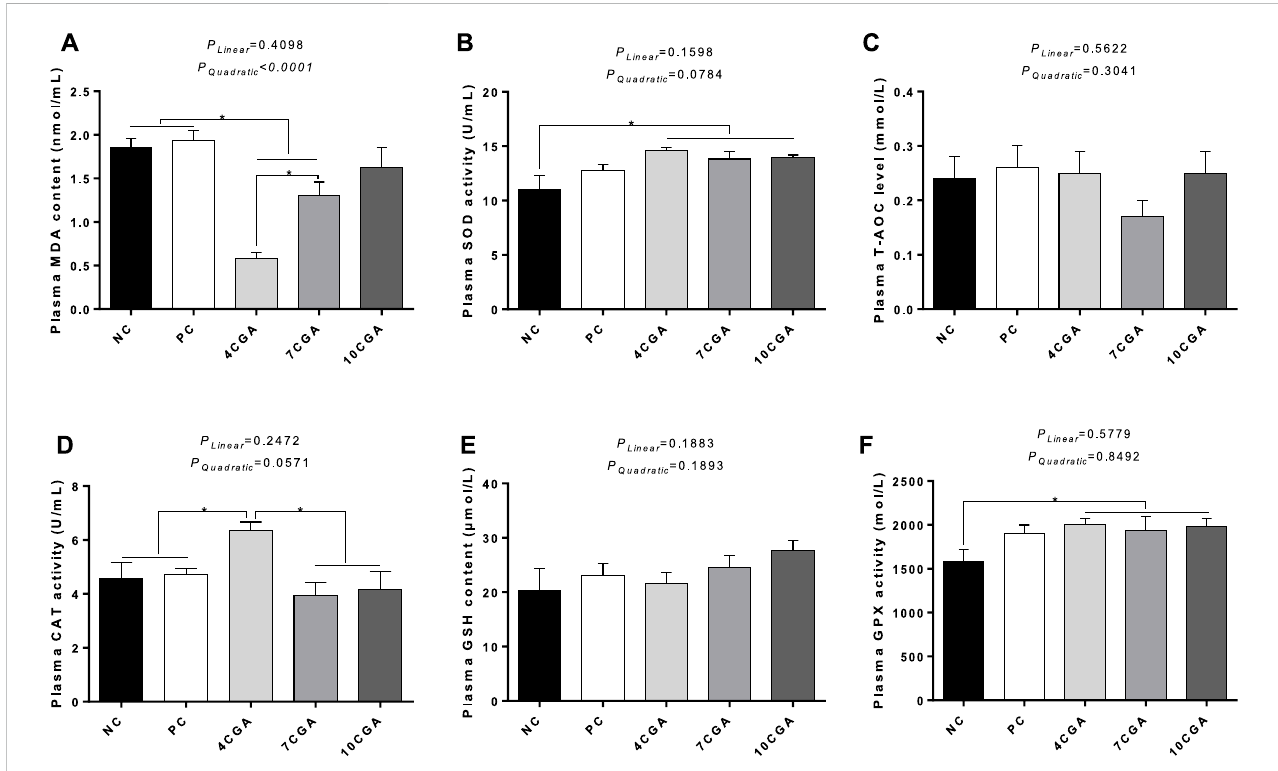
FIGURE 3 Effects ofinovo feeding ofchlorogenic acid on plasmaoxidationand antioxidant parametersof42-heatstressed broilers. (A) MDA; (B) SOD; (C) T-AOC; (D) CAT; (E) GSH; (F) GPX. * indicates a signi fi cant difference between treatments ( p < 0.05), n = 6.